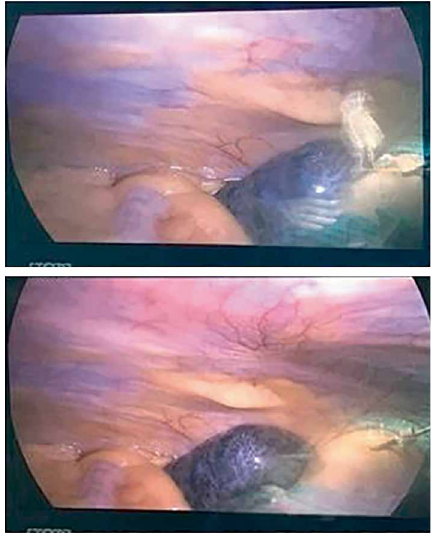
Figure 2: Dark purple discoloration of left ovary.